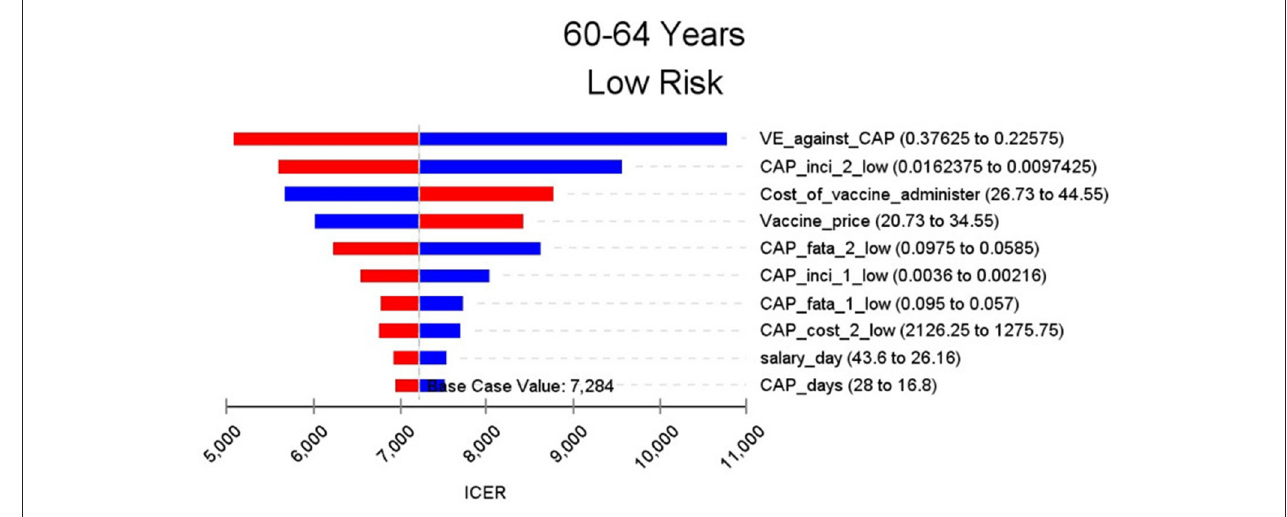
FIGURE 2 | Sensitivity analysis in group 60–64 years and low risk.